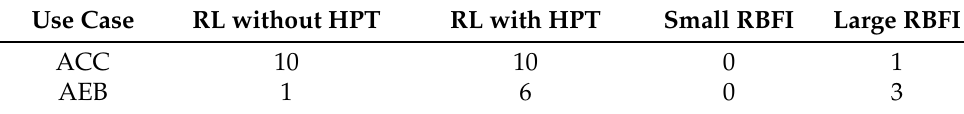
Table 6. Number of found